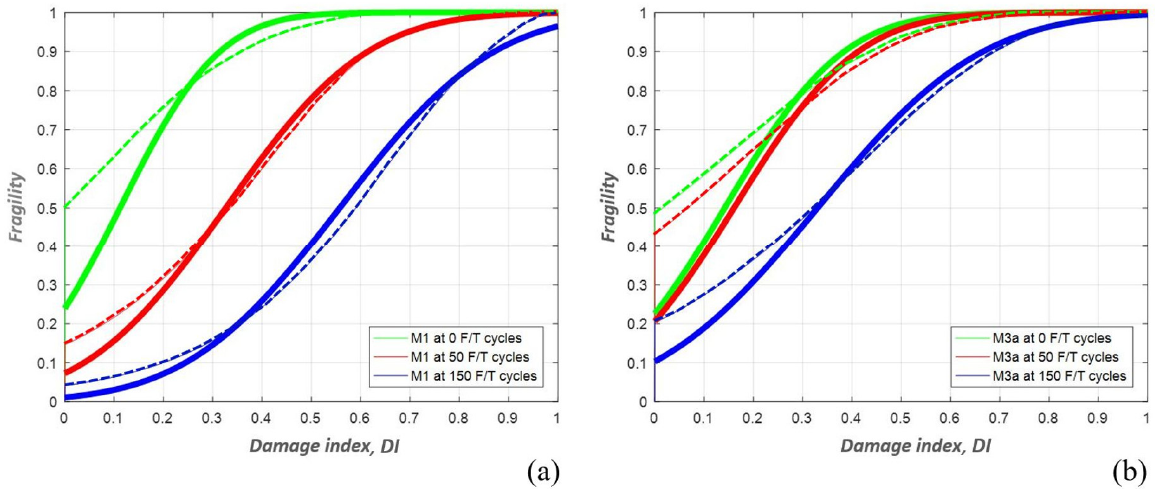
Figure 5. Normal and log-normal fragility curves for the damage index for M1 ( a ) and M3a ( b ) wallets. Bold and dashed lines correspond to the fitted theoretical cdfs based on the normal (bold) and log-normal (dashed) probability distributions, respectively.